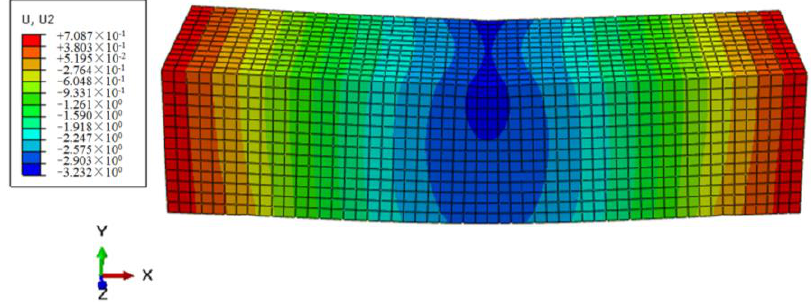
Figure 6. Vertical displacement contours of the control at 3600 s.